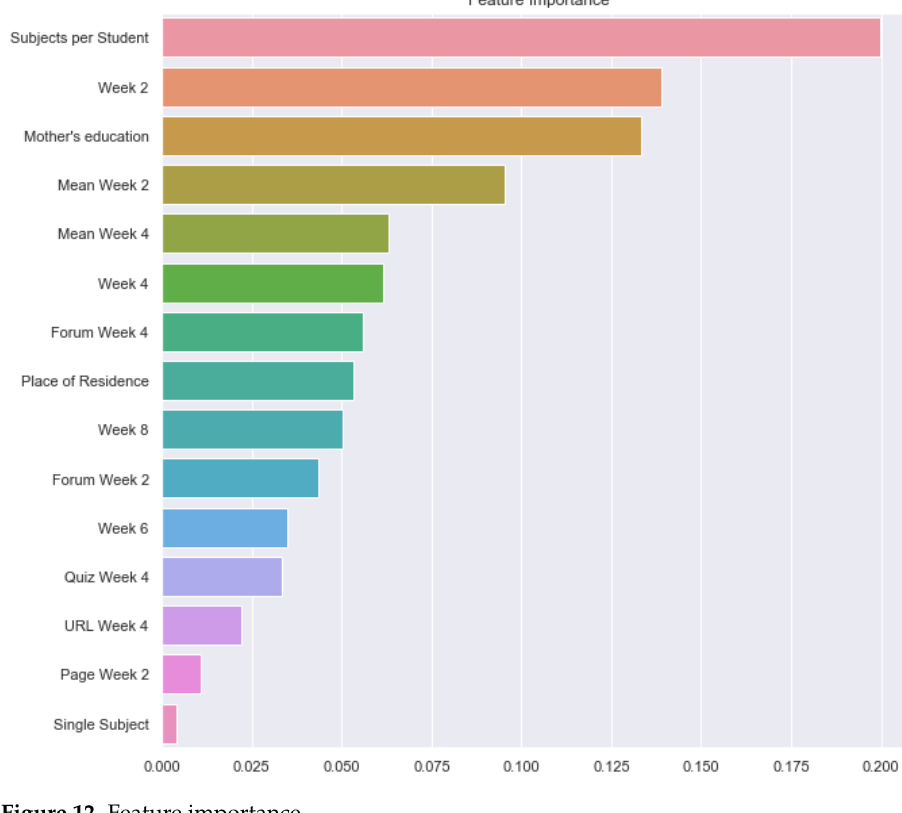
Figure 12. Feature